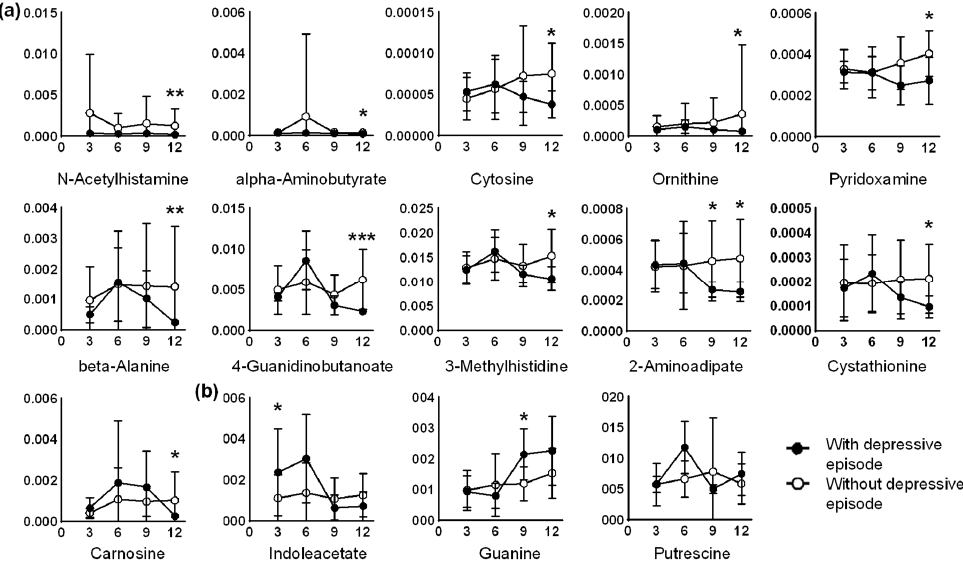
Figure 3. Time-series changes in metabolites that differed between the depressive episode and non- depressive episode groups. Metabolites showing significant differences at the ( a ) 12-month and ( b ) shorter stays are shown. Mean values and standard deviations are shown as plots and error bars, respectively. The X-axis indicates the length of stay (months) and the Y-axis indicates the metabolite concentration divided by the creatinine concentration (unitless). * p < 0.05, ** p < 0.01, *** p < 0.001.